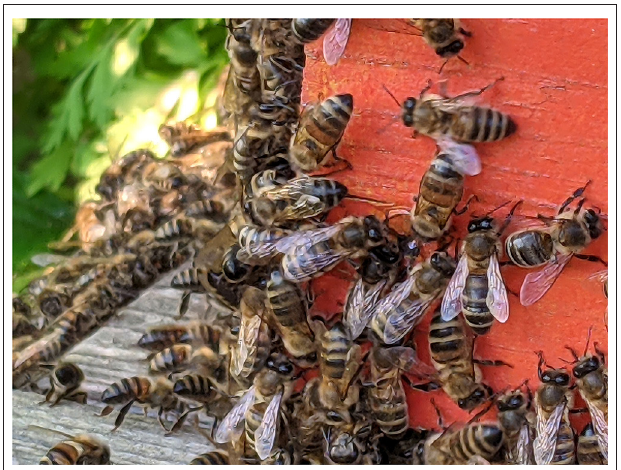
FIGURE 7 | Honeybees in Kent, UK.